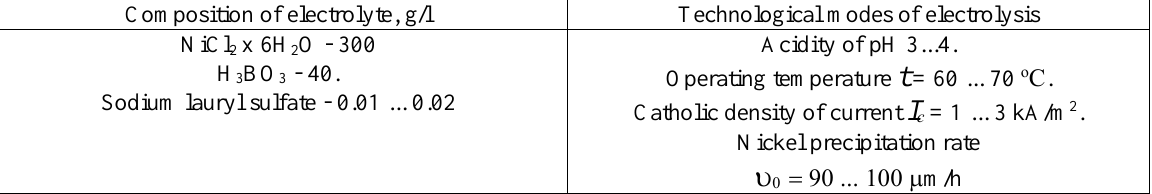
Composition and characteristics of a nickel of electrolyte chloride [6, 7] Composition of electrolyte, g/l Technological modes of